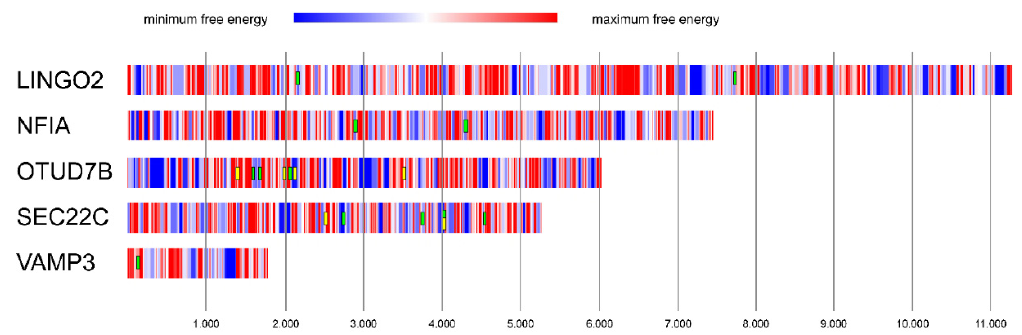
Figure 10. Prediction of RNA–RNA interaction between LINC00518 and mRNAs. Graphical representation of free energy (kJ) computed from the binding of LINC00518 and the 3 (cid:48) -UTRs of the regulated mRNAs. A color-coded scale, based on free energy values, is used to depict the 3 (cid:48) -UTRs of mRNAs: blue regions represent the binding tracts with minimum free energy, and, accordingly, they represent the most reliable binding regions. The boxes represent miRNAs binding to minimum free energy regions: LINGO2 : miR-497-5p; NFIA : miR-143-3p; OTUD7B : miR-145-5p (green) and miR-497-5p (yellow); SEC22C : miR-199a-5p (green) and miR-212-5p (yellow); VAMP3 : miR-3191-3p. Free energy scale limits: (1) LINGO2 : minimum = − 28.57, maximum = 2.32; (2) NFIA : minimum = − 20.18, maximum = 2.14; (3) OTUD7B : minimum = − 33.26, maximum = 8.07; (4) SEC22C : minimum = − 27.55, maximum = 1.09; and (5) VAMP3 : minimum = − 23.87, maximum = − 0.59. Nucleotide position of the 3 (cid:48) UTR of each mRNA is shown.